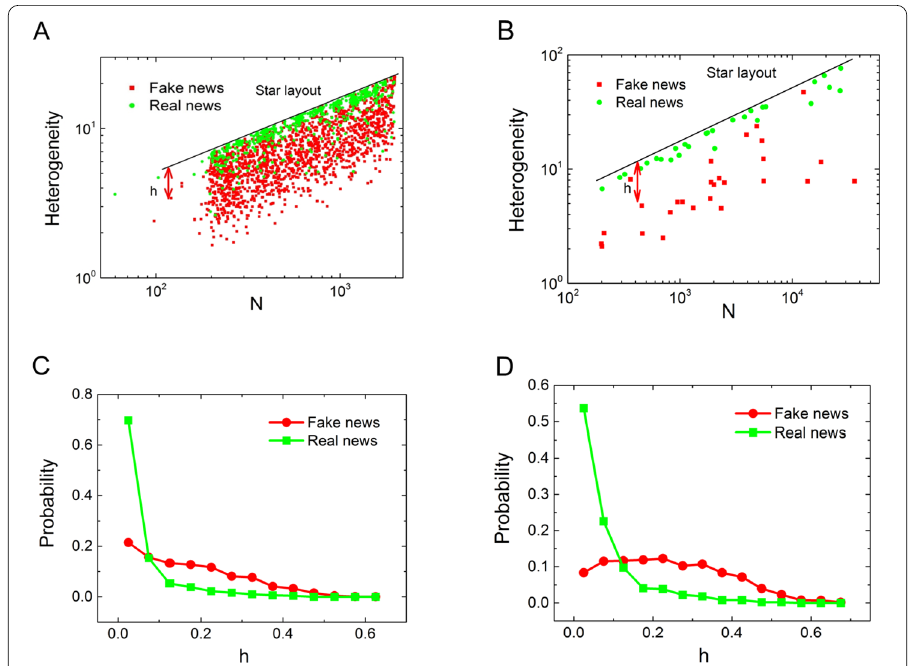
Figure 5 Heterogeneity measure for fake and real news in Weibo and Twitter. ( A ) The x axis is the size of the propagation network, and the y axis is the heterogeneity measure of the networks. The black line is the value of the star layout. The h is the difference of heterogeneity value between a real network and the corresponding value of star layout. ( B ) The scatter plot like in ( A ) for Twitter. ( C ) Distribution of h at five hours from the first re-posting of the Weibo propagation networks. The p -value here is below 0.01. ( D ) Distribution of h of all re-postings in Weibo for the whole lifespan. The p -value is below 0.01